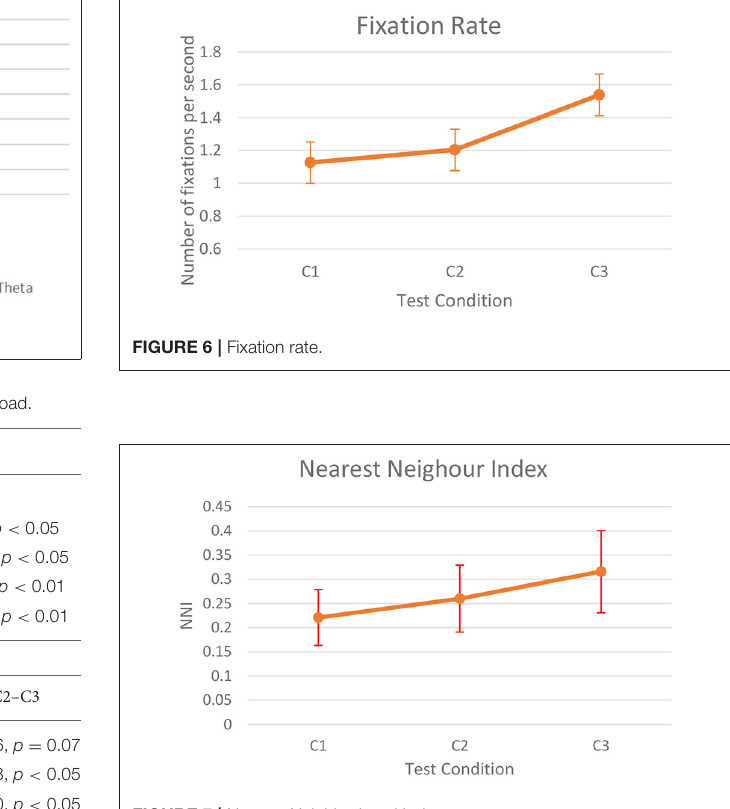
FIGURE 7 | Nearest Neighborhood